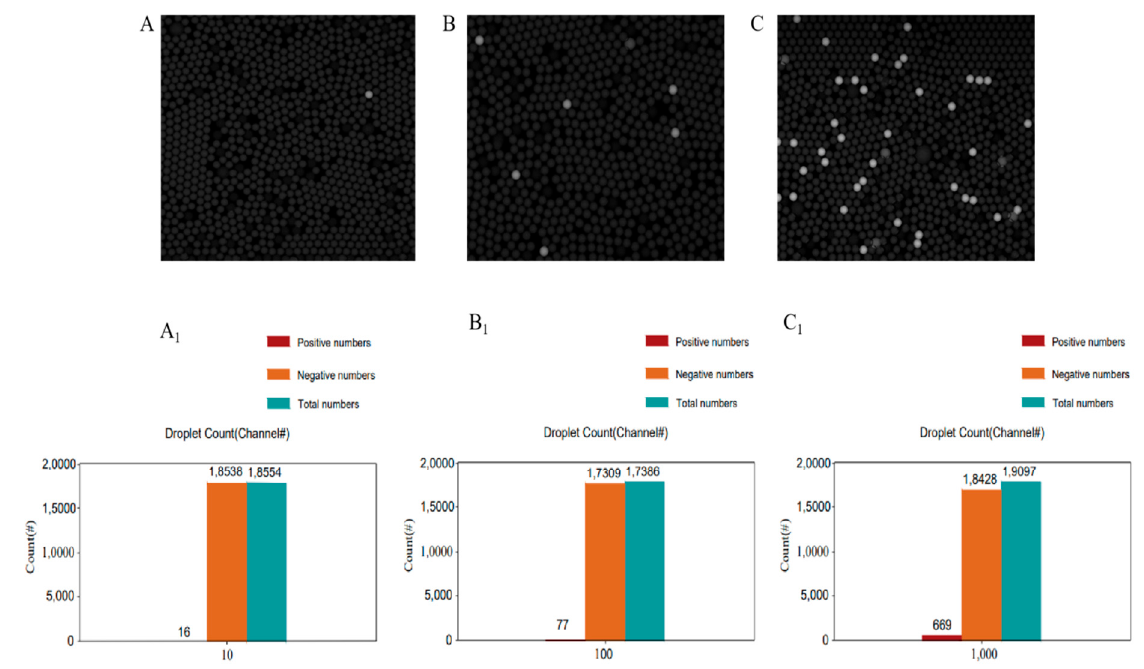
Figure 4. ( A ) RT-LAMP-BART bioluminescent droplet images prepared using an optimized BART reagent mixture. The target RNA template concentration was 10 4 copies/mL. ( A 1 ) Droplet count of the reaction shown in ( A ). Positive droplets: 9; negative droplets: 19,574; total droplets: 19,583. ( B ) RT-LAMP-BART bioluminescent droplet images prepared using an optimized BART reagent mixture. The target RNA template concentration was 10 5 copies/mL. ( B 1 ) Droplet count of the reaction shown in ( B ). Positive droplets: 77; negative droplets: 17,309; total droplets: 17,386. ( C ) RT-LAMP-BART bioluminescent droplet images prepared using an optimized BART reagent mixture. The target RNA template concentration was 10 6 copies/mL. ( C 1 ) Droplet count of the reaction shown in ( C ). Positive droplets: 669; negative droplets: 18,428; total drop-